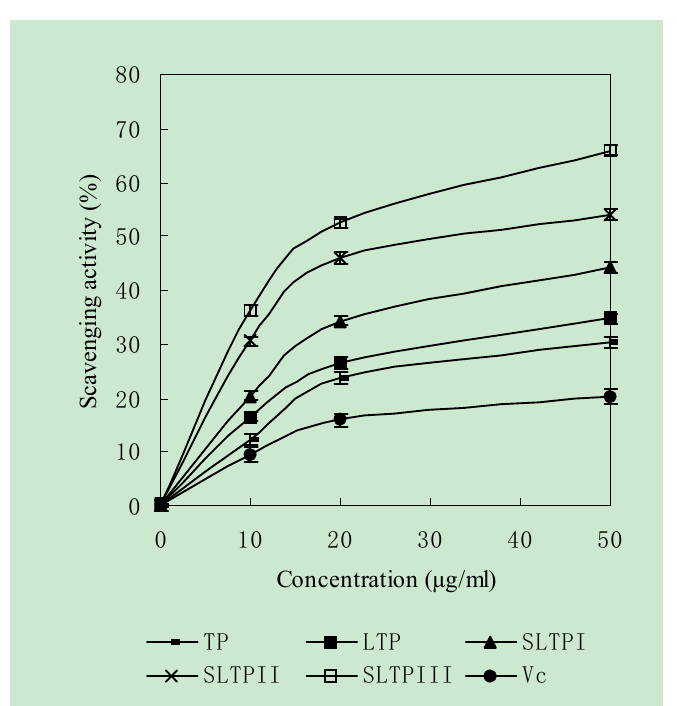
Figure 3. Scavenging activity of natural TP, its derivatives and Vitamin C against hydroxyl radicals. Values were means ± SD (n =